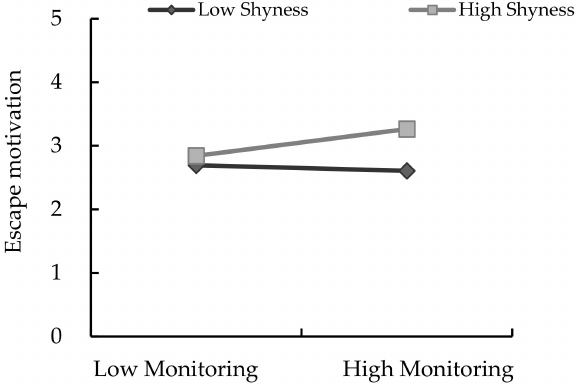
Figure 2. Moderation e ff ects of shyness in the mediation model. All values shown are standardized coe ffi cients. + p < 0.10. * p < 0.05. *** p < 0.001.